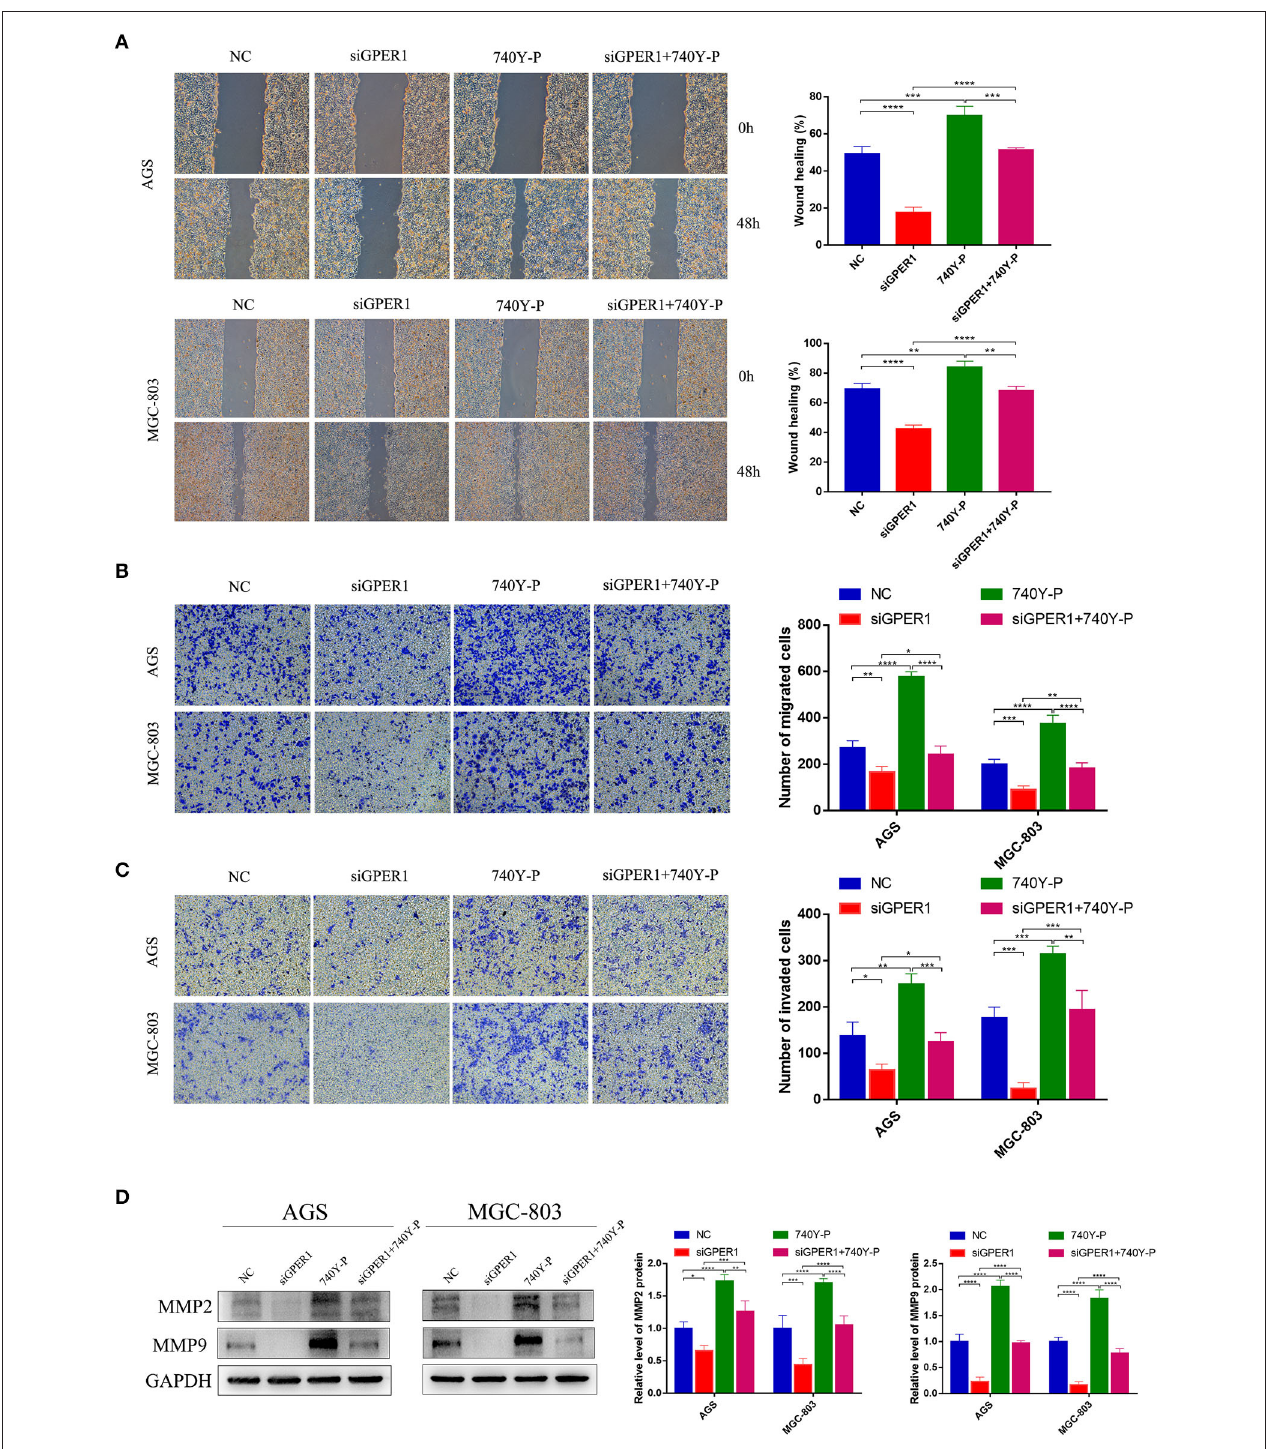
FIGURE 4 | GPER1 knockdown impairs the migration and invasion of AGS and MGC-803 cells. (A) Cell mobility was detected by wound healing assay; (B) cell migration and (C) invasion were detected by transwell assays; (D) . Western blot analysis of matrix metalloproteinase 9 (MMP9) and MMP2 protein expression. GAPDH was used as a loading control. Control, cells without transfection; GPER1, cells transfected with GPER1 siRNA; 740Y-P, cells treated with 740Y-P; GPER1 + 740Y-P, cells transfected GPER1 siRNA and then treated with 740Y-P. Results were shown as mean ± SD of three independent experiments, each experiment was performed in triplicate. * P < 0.05; ** P < 0.01; *** P < 0.001; **** P < 0.0001.